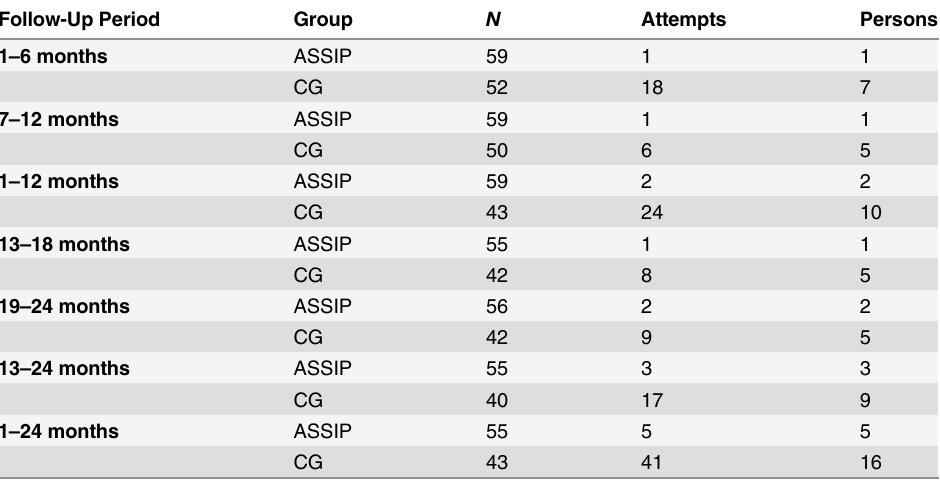
ASSIP group: ASSIP therapy plus TAU ( n = 60); control group (CG): clinical assessment plus TAU ( n = 60); person sums include individuals with more than one suicide